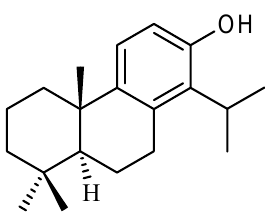
Figure 2. Chemical structure of